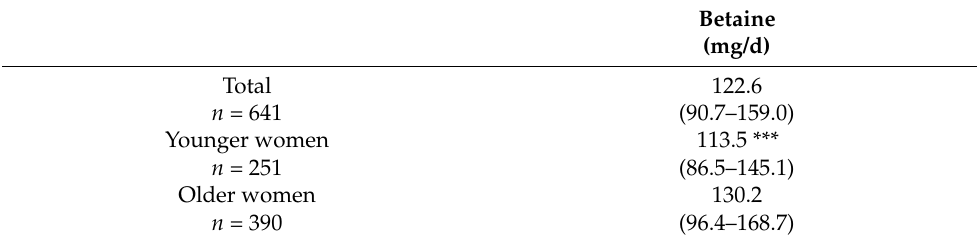
Table 4. Betaine intake in women of childbearing age from the ANIBES